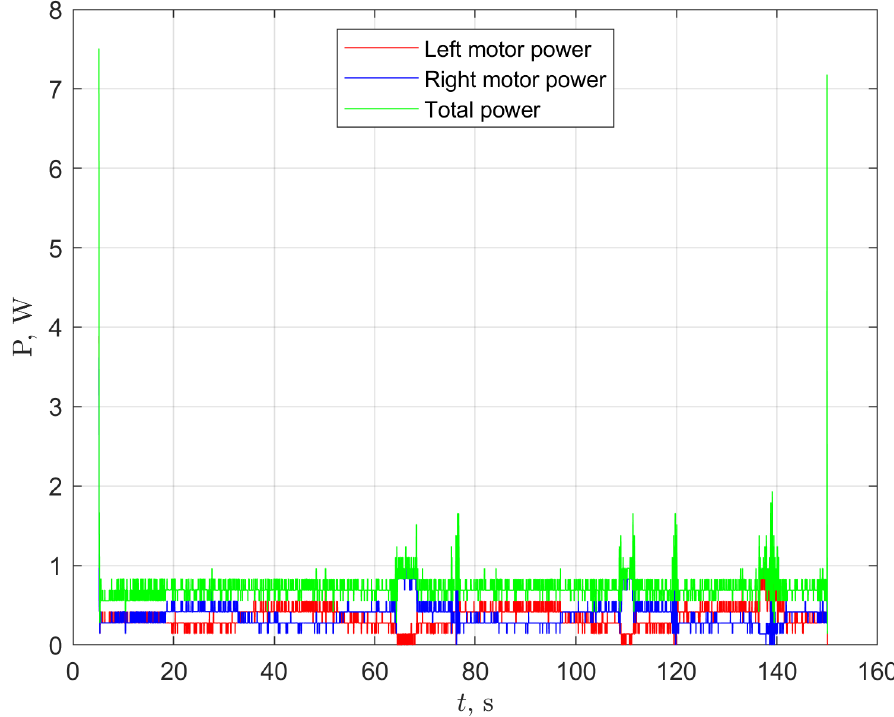
Figure 16. Individual motor power and the total power over time, for the highest value of the cost function equal to 1.2970—track